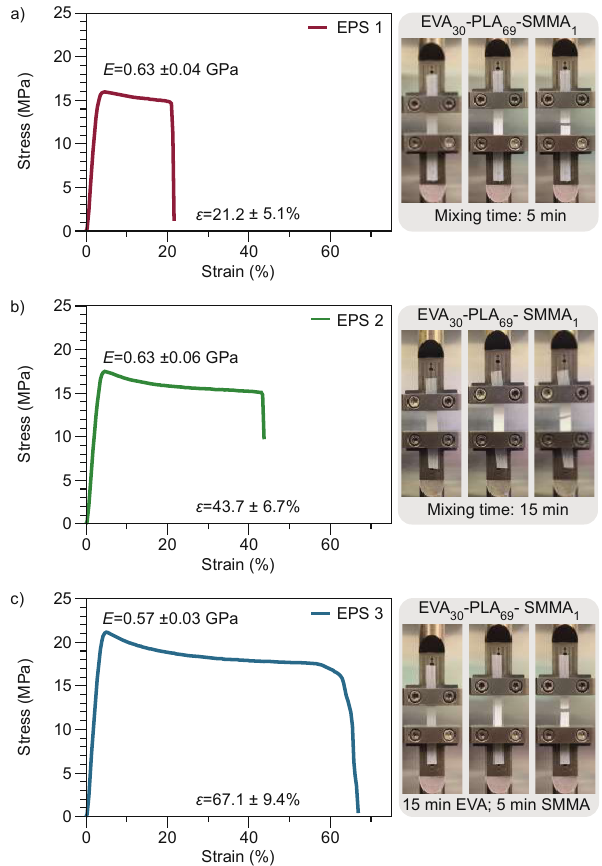
Figure 1. Stress vs strain curves of ternary blends. ( a ) EVA 30 -PLA 69 -SMMA 1 (mixing time 5 min), EPS 1. ( b ) EVA 30 -PLA 69 -SMMA 1 (mixing time 15 min), EPS 2. ( c ) EVA 30 -PLA 69 -SMMA 1 (mixing time 15 min EVA and 5 min SMMA), EPS 3.